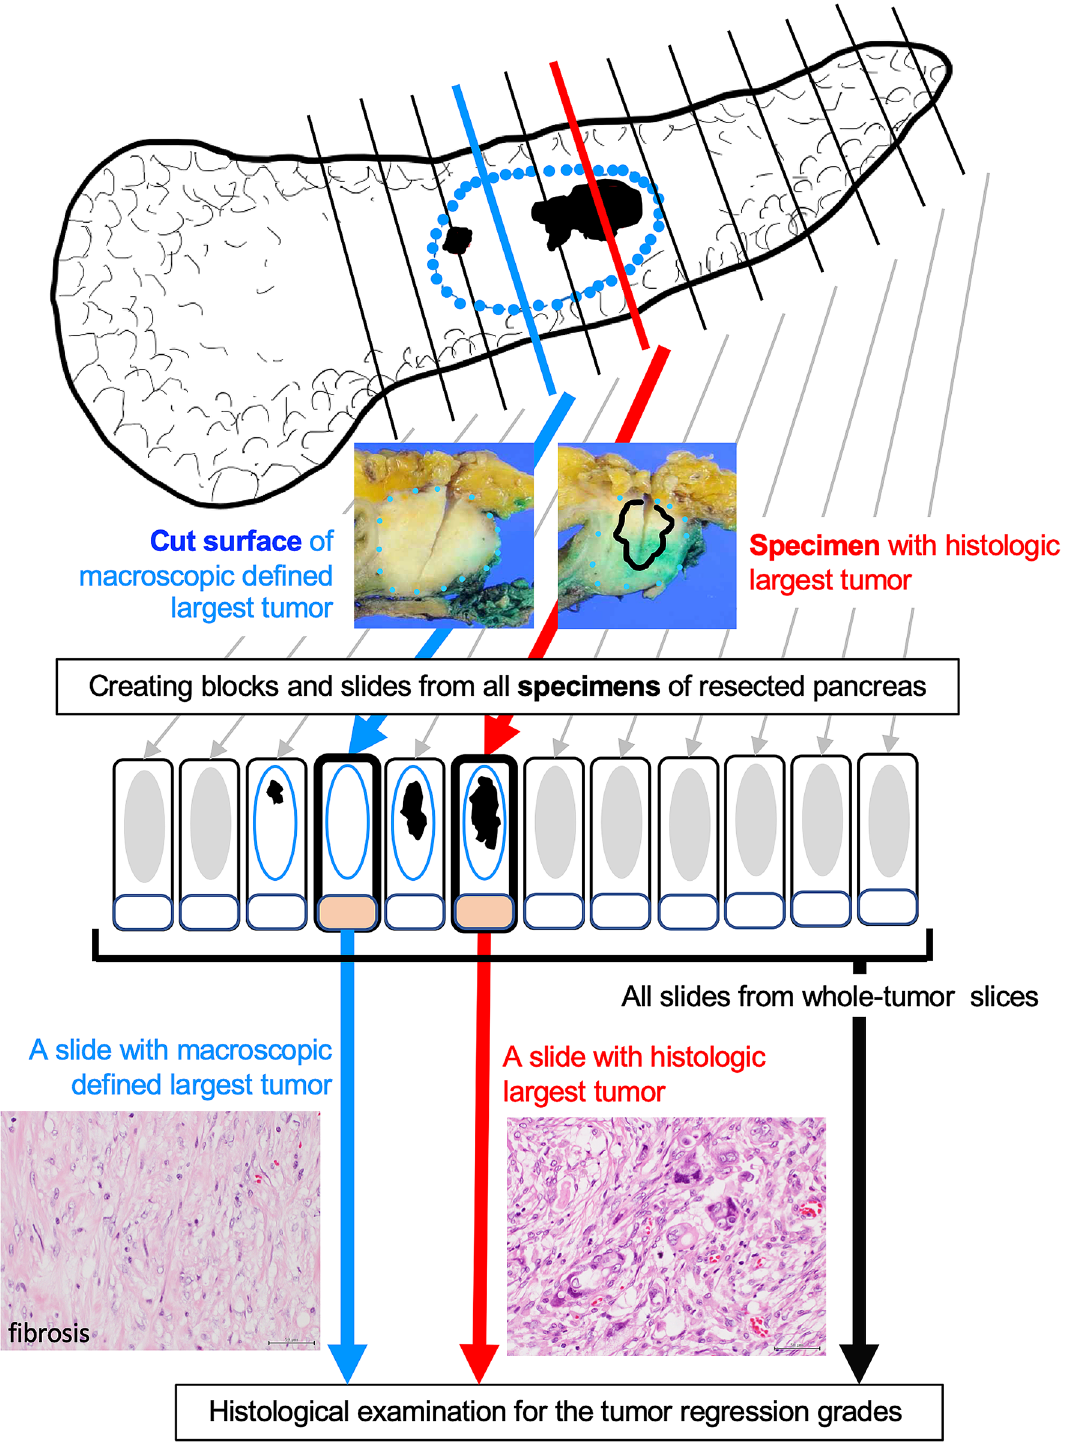
Figure 3. Comparison of tumor regression grades from different slides. Distal pancreatectomy sample was sliced perpendicular to the main pancreatic duct at a 5-mm interval. Tissue blocks were created from all specimens. For pathological analysis, glass slides were created from all blocks. Tumor regression grades were evaluated from a slide with the cut surface of macroscopic defined largest tumor, a slide with largest histological tumor, and all slides from whole-tumor slices. Dotted line: fibrosis after neoadjuvant therapy; black-out area or black grid-line: cancers identified